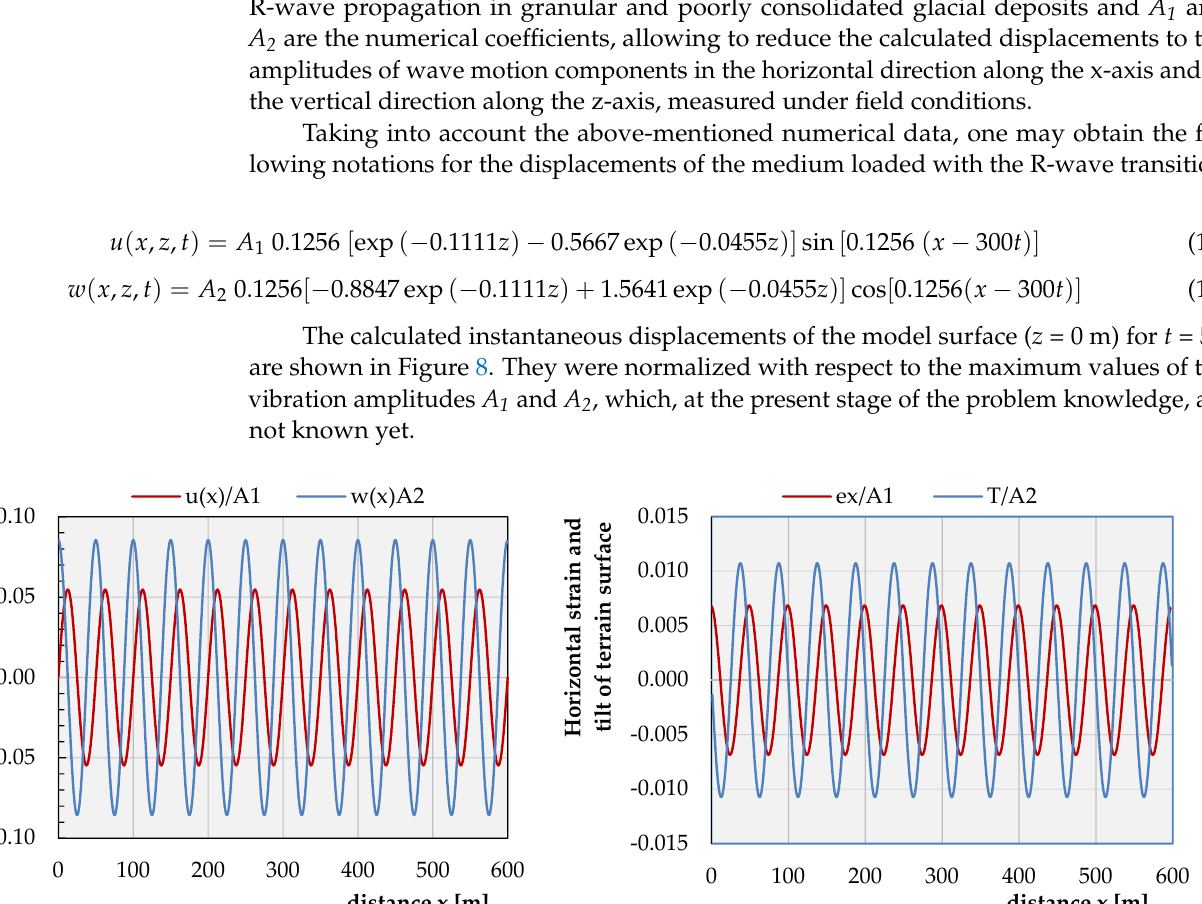
Figure 9. Displacement trajectories of the points located on the surface of an elastic half-space for the case under consideration ( ν = 1/3).